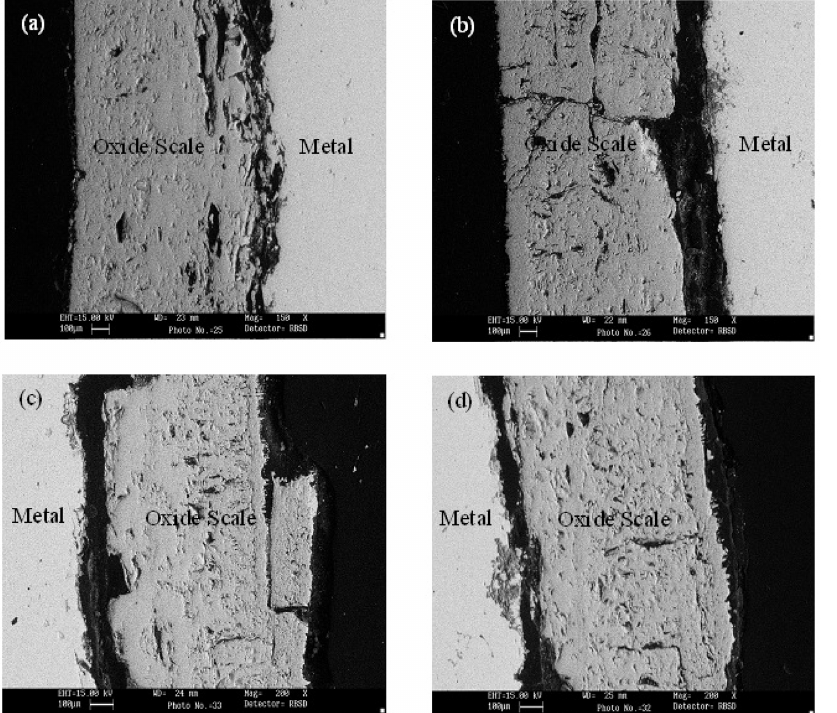
Figure 4: SEM back scattered image of the cross section of welded steels after cyclic oxidation in air at 900°C for 50 cycles (a) weld metal